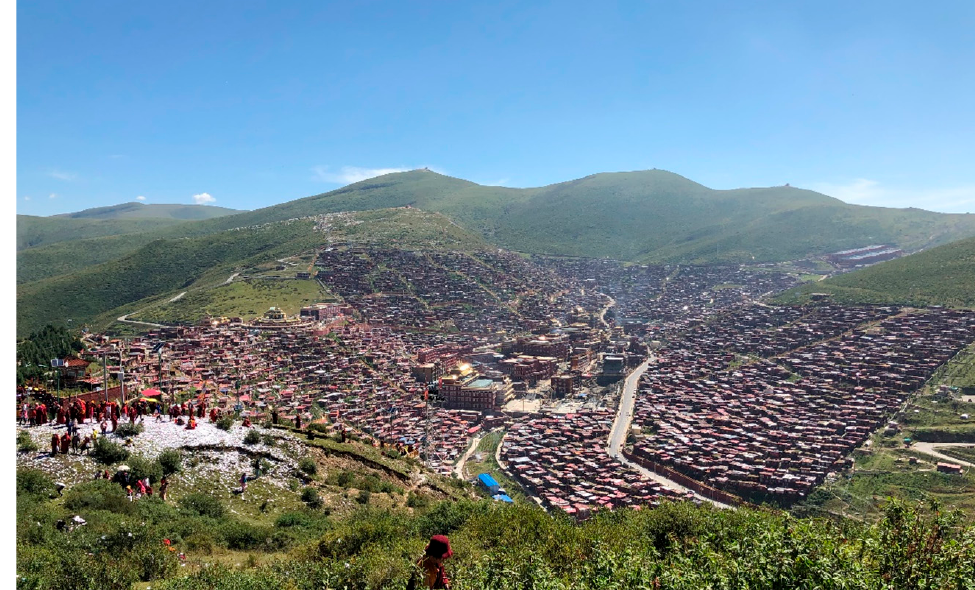
Figure 1. Larung Gar Buddhist Academy, China (photo by primary